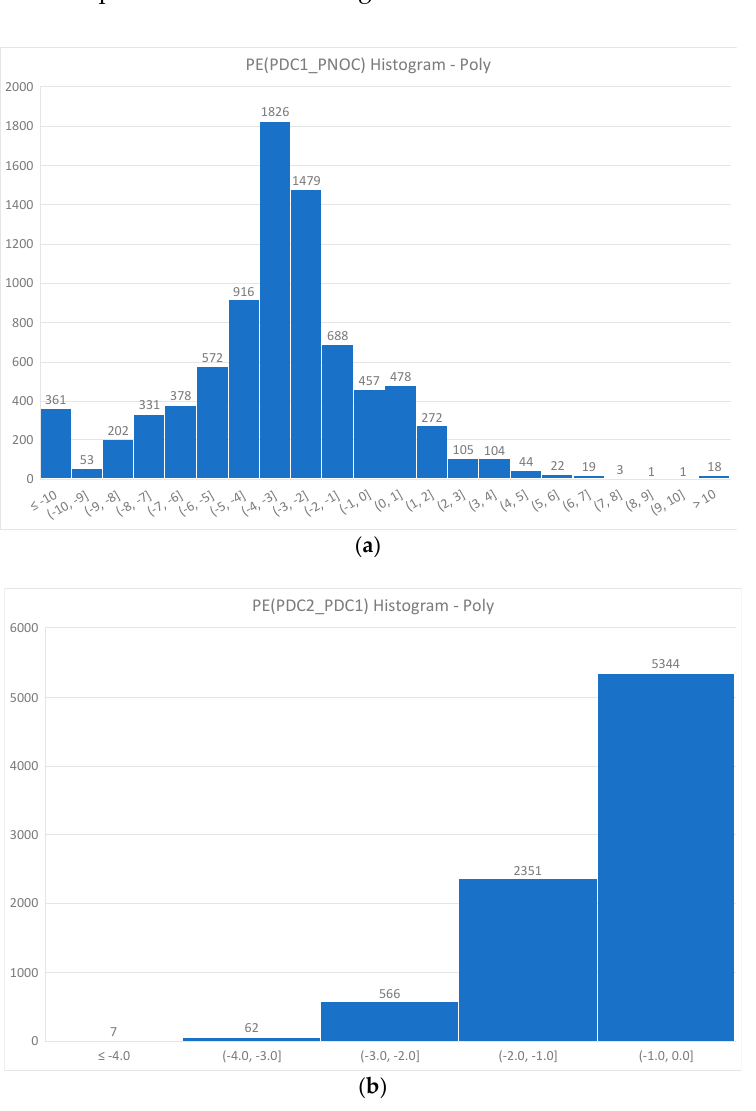
Figure 4. Histograms of the Percentage Error 𝑃𝐸 (cid:2869)(cid:3015)(cid:3016)(cid:3004) concerning 𝑃𝐷𝐶 (cid:2869)(cid:3015)(cid:3016)(cid:3004) and 𝑃 (cid:3015)(cid:3016)(cid:3004) ( a ), and the Percentage Error 𝑃𝐸 (cid:2870)(cid:3015)(cid:3016)(cid:3004) concerning 𝑃𝐷𝐶 (cid:2870)(cid:3015)(cid:3016)(cid:3004) and 𝑃𝐷𝐶 (cid:2869)(cid:3015)(cid:3016)(cid:3004) ( b ); monocrystalline modules.